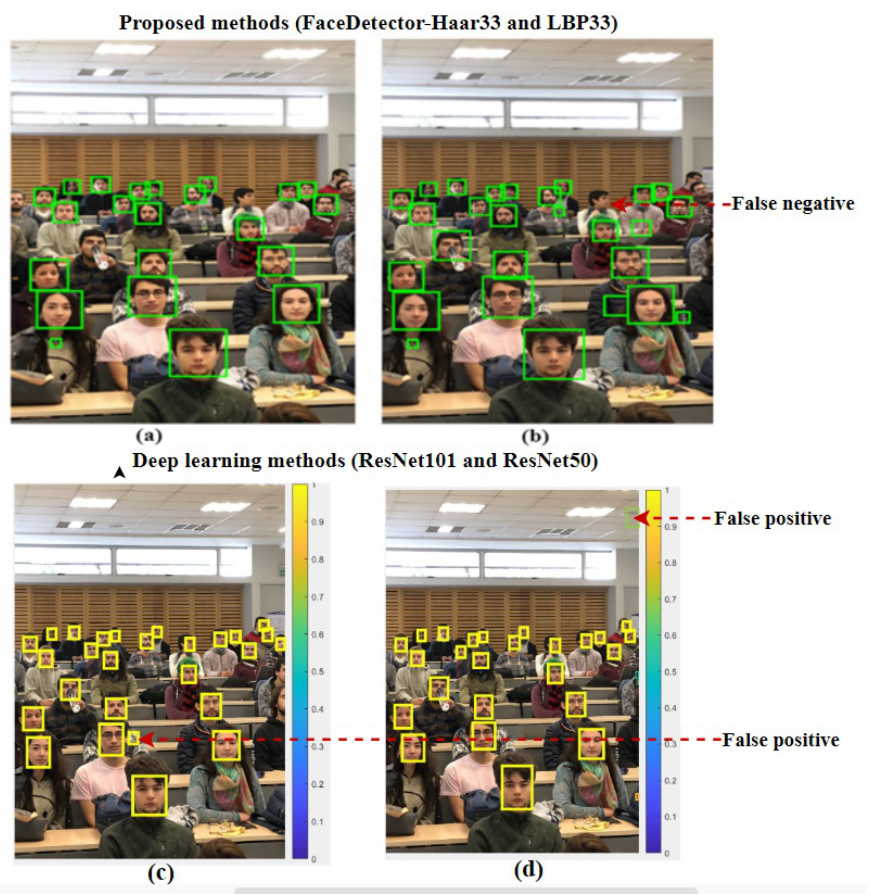
Figure 9. Faces detected by ( a ) Haar-like and ( b ) LBP custom face detector at 0.1 FAR for 8-layers of cascade stages. Subimages ( c , d ) are the output from ResNet101 and ResNet50,